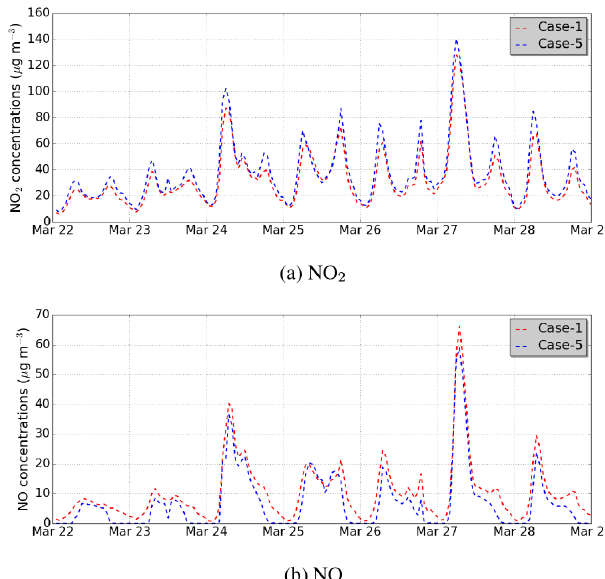
Figure 10. Comparison of (a) NO 2 and (b) NO hourly concentra- tions using the non-stationary approach (Case-1) in red and the sta- tionary approach (Case-5) in blue. The concentrations are averaged over the whole simulation